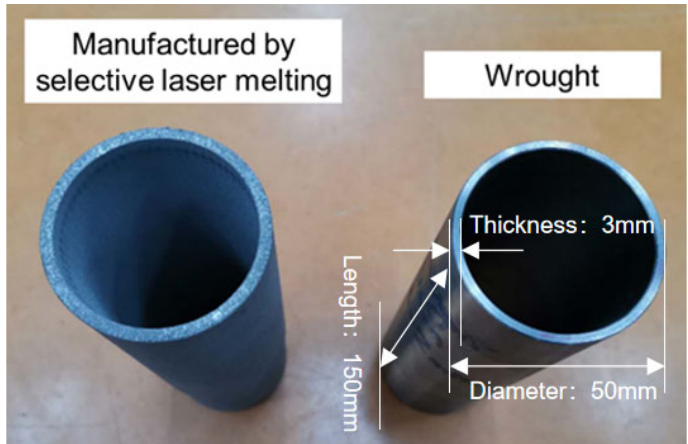
Figure 1. The wrought and additive ‐ manufactured Ti6Al4V